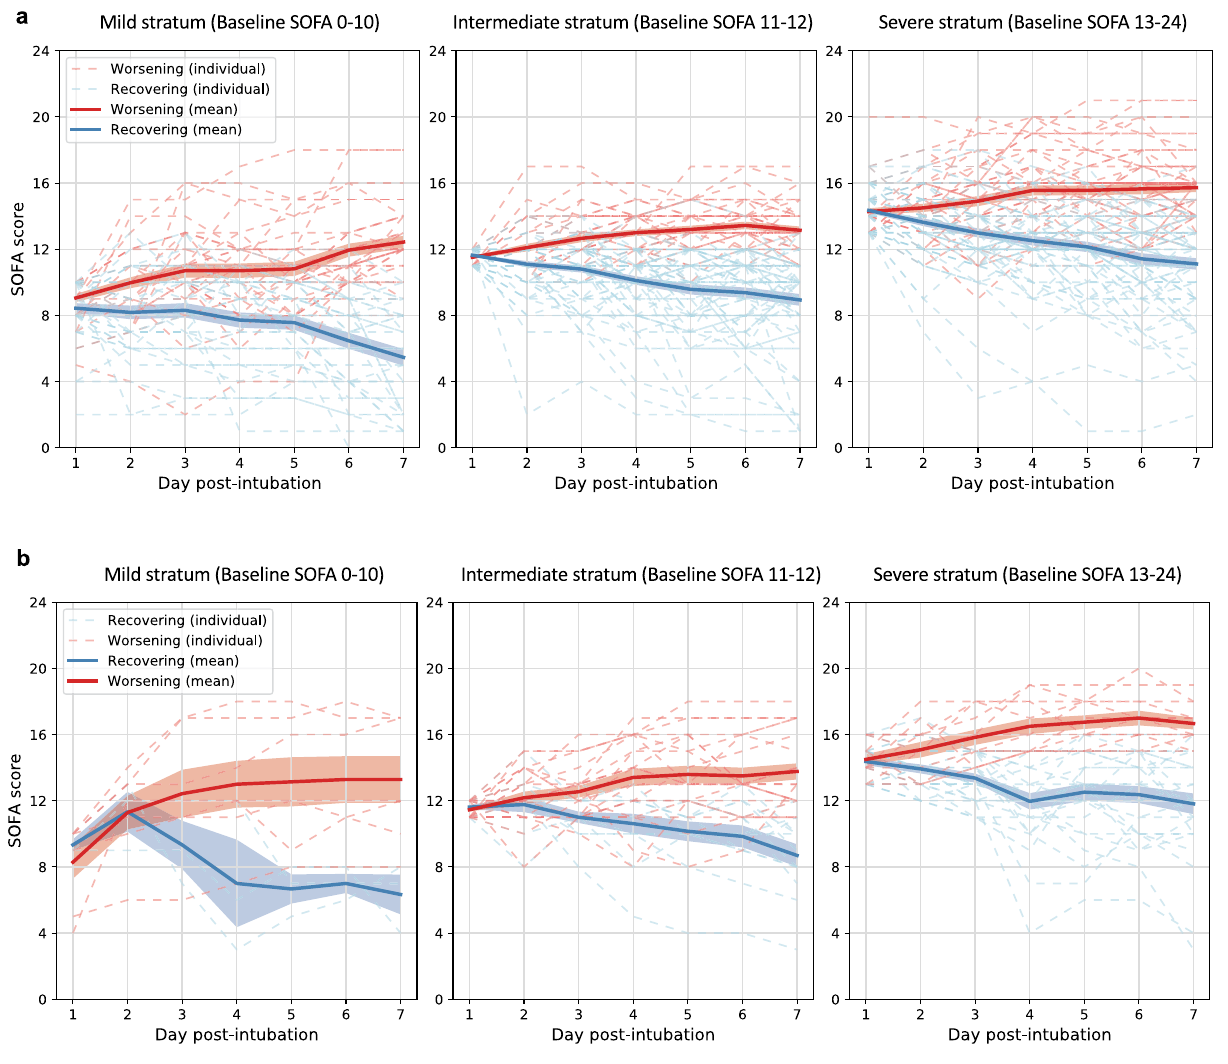
Figure 2. Averaged Sequential Organ Failure Assessment (SOFA) trajectories of the identified subphenotypes. ( a ) SOFA trajectories of subphenotypes derived in NYP-WCMC cohort. ( b ) SOFA trajectories of subphenotypes derived in NYP-LMH validation cohort. Solid curves are mean SOFA trajectories of the subphenotypes, while shadow represents 95% confidence interval. Dashed curves are individual SOFA trajectories of the